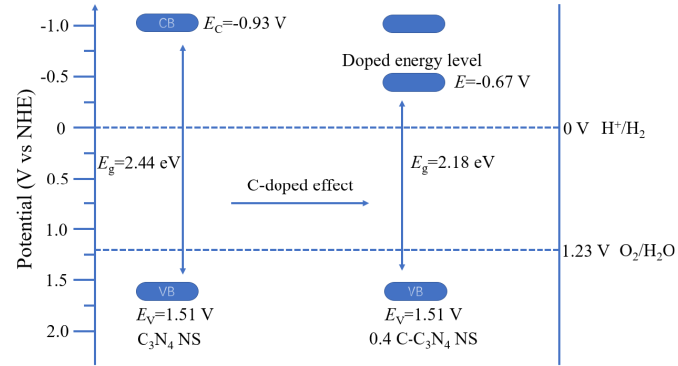
Figure 9. Band structure of the C 3 N 4 NS and 0.4 C-C 3 N 4 NS.